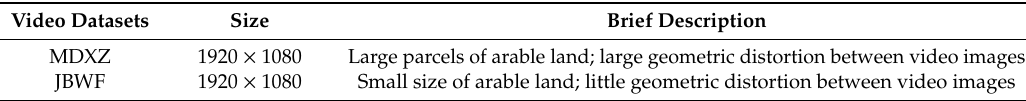
Table 1. The experimental